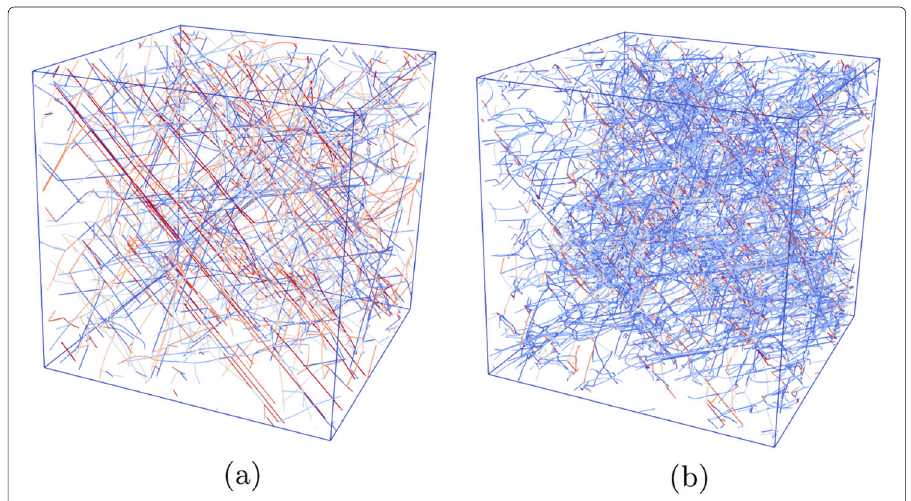
Fig. 1 a Relaxed configuration used as initial configuration in the simulations. b Configuration at γ d = 5% shear strain along [4910]